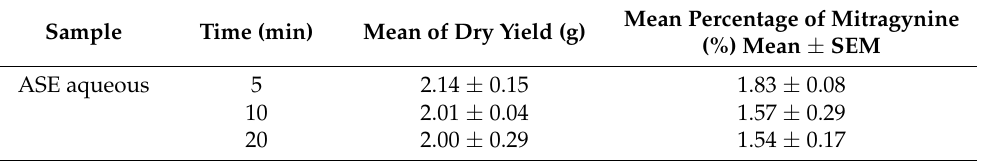
Table 1. Dry yield and mitragynine content in M. speciosa ASE leaves extracted with water for 5, 10, and 20